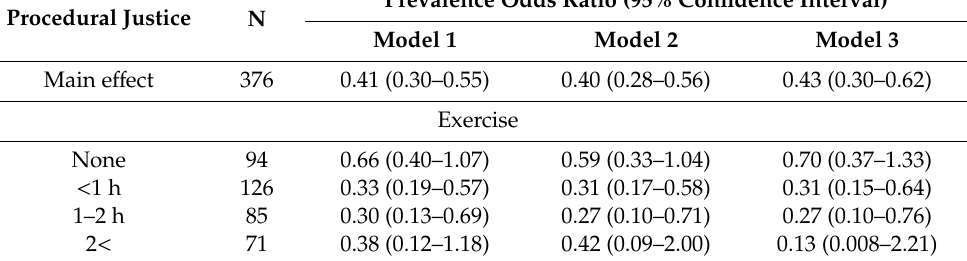
Table 3. Association of procedural justice with psychological well-being by regular exercise among Korean